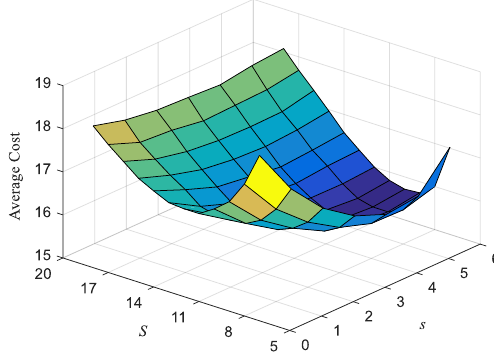
Figure 1. The average cost with respect to 𝑠 and 𝑆